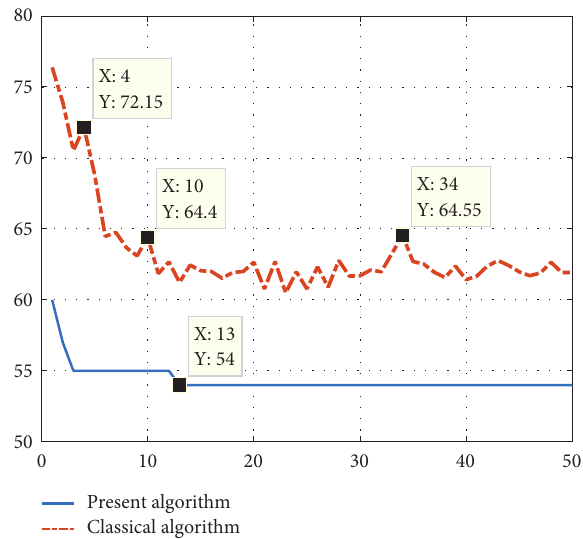
Figure 9: MAE comparison between the proposed algorithm and the classical